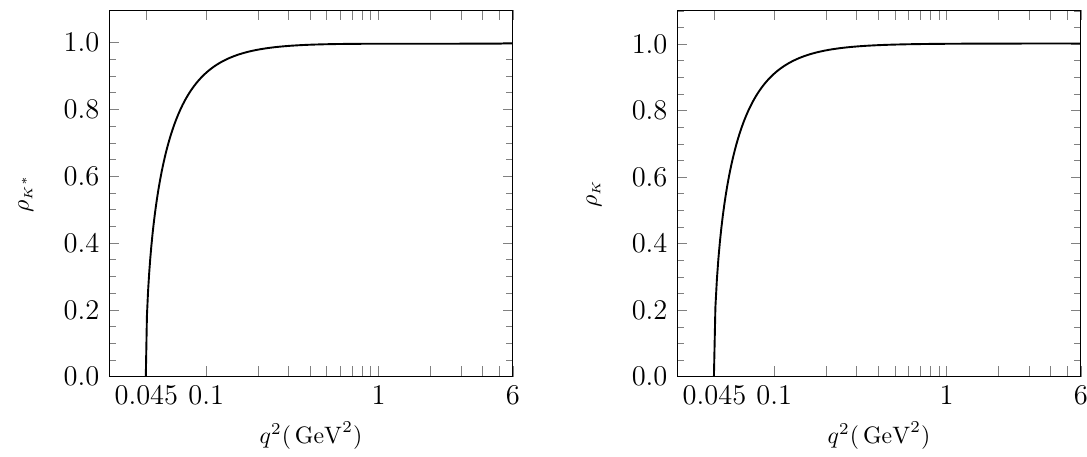
Figure 5 . The (cid:26) K;K (cid:3) functions at the LO in the SM as de(cid:12)ned in the text, as a function of q 2 , for the B ! K (cid:3) ‘ + ‘ (cid:0) (left plot) and B ! K‘ + ‘ (cid:0) (right plot) decays. are reported in the left plot of (cid:12)gure 6. The LO SM contribution to the (cid:26) is almost the same for the B ! K (cid:3) and B ! K transitions, the largest di(cid:11)erence is of the order of 1{2% for q 2 < 0 : 5 GeV 2 . Concerning the magnetic-dipole corrections, as we can see